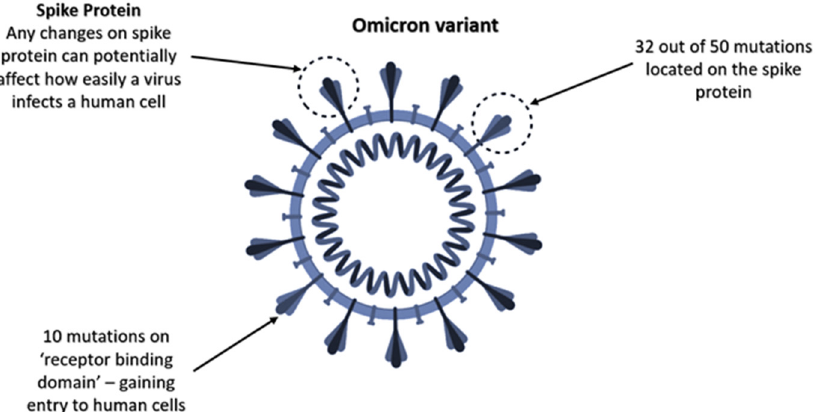
Figure 2. The new COVID-19 variant: Omicron (B.1.1.529).